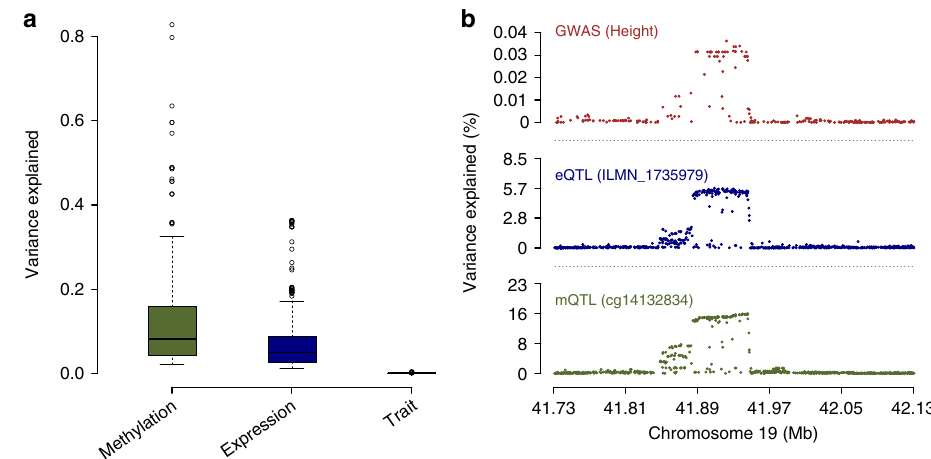
Fig. 7 The attenuation of effect sizes of genetic variants on methylation and gene expression towards complex traits. a Distribution of the variance explained in methylation, gene expression and trait phenotypes by the top mQTLs for the 149 DNAm that are signi fi cantly associated with both 66 transcripts and 12 traits. Of 225 DNAm – transcript pairs, there are 160 pairs for which the mQTL effect is higher than the eQTL effect (both in SD units). b An example of a genomic locus for height, where the SNP-association signals are consistent across mQTL, eQTL and GWAS, indicating a single shared underlying causal variant, but the variance explained decreases dramatically across these